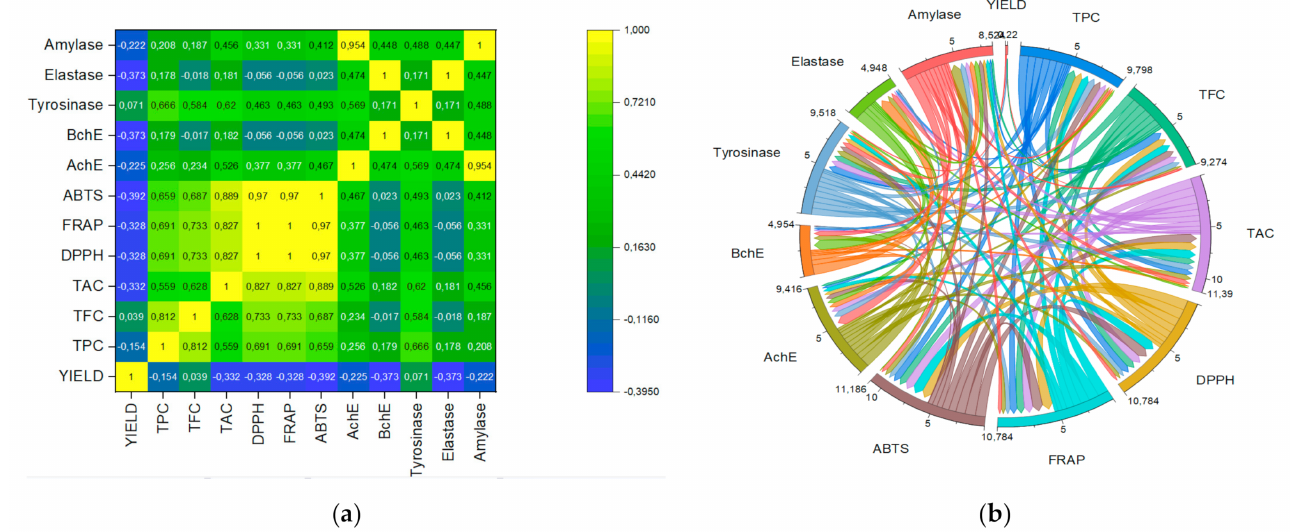
Figure 2. ( a ) Pearson’s correlation coefficient (R) and ( b ) chord diagram presenting the correlation between polyphenolics and biological properties. AchE and BchE are acetylcholinesterase and butyrylcholinesterase inhibition activities,